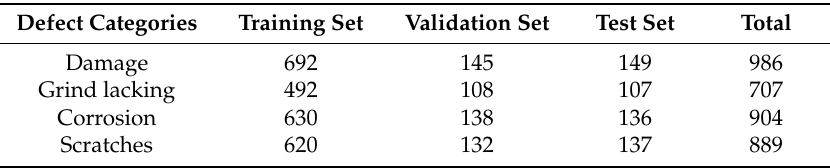
Table 2. Defect data statistics.